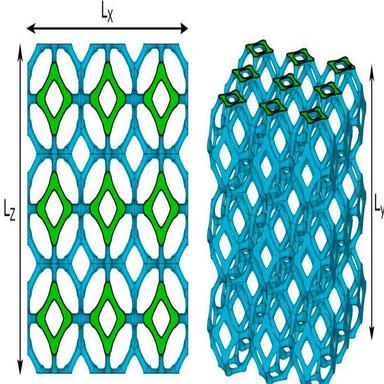
Dimensions of a 3 × 3 × 3 cells foam domain.